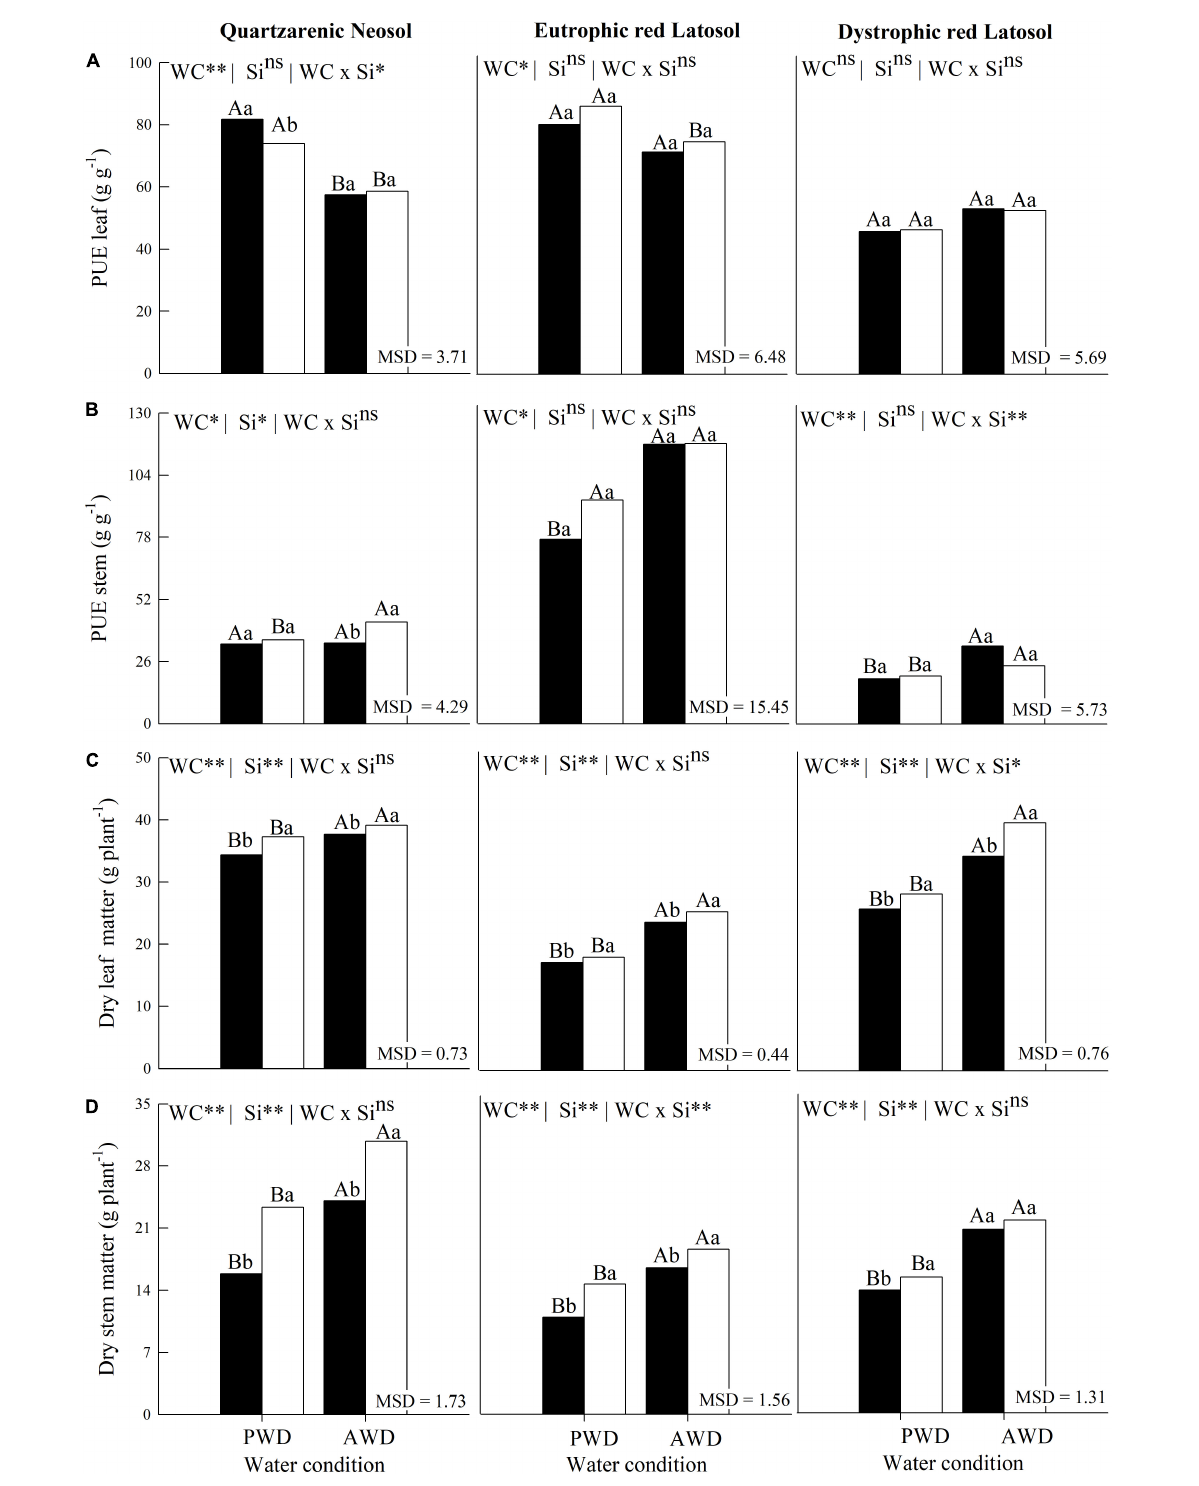
FIGURE5 Phosphorus use efficiencies (A,B) and dry mass partition (C,D) in leaves and stems of sugarcane cultivated with absence (0.0 mM) and presence of fertigated Si (1.8 mM) and two water conditions (without—AWD and with water deficit—PWD) in three tropical soils (Quartzarenic Neosol; Eutroferric Red Latosol; and Dystrophic Red Latosol). PUE, P use efficiency; WC, water condition; MSD, Minimum significant difference; ** and *: significant at 1 and 5% probability, respectively; NS, not significant at 5% probability. Different uppercase letters indicate differences in water conditions and different lowercase letters indicate differences in Si fertigation by Tukey’s test ( p <